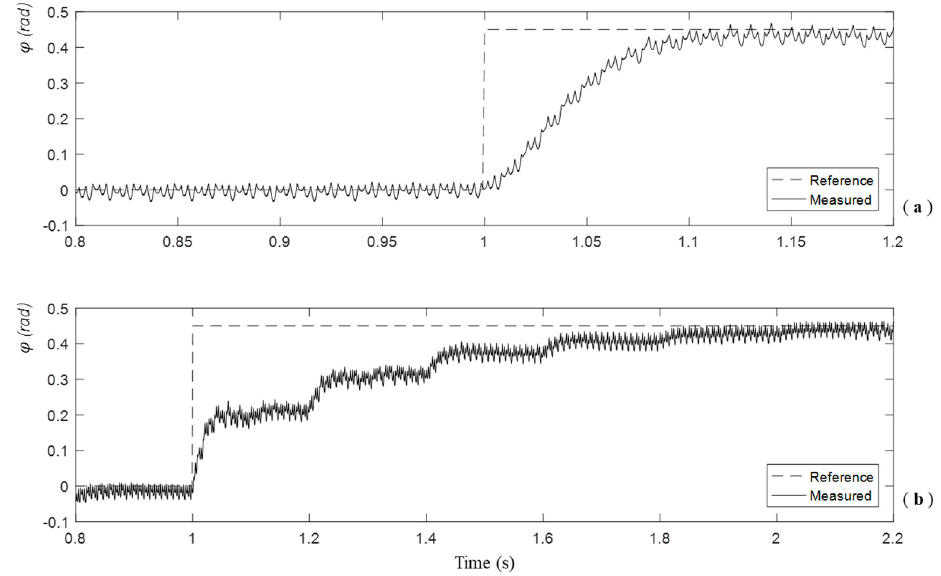
Figure 9. ( a ) Angle tracking, ( b ) grid phase-to-neutral voltages, ( c ) injected currents and ( d ) capacitor voltage of cells with a power increment in the second scenario.